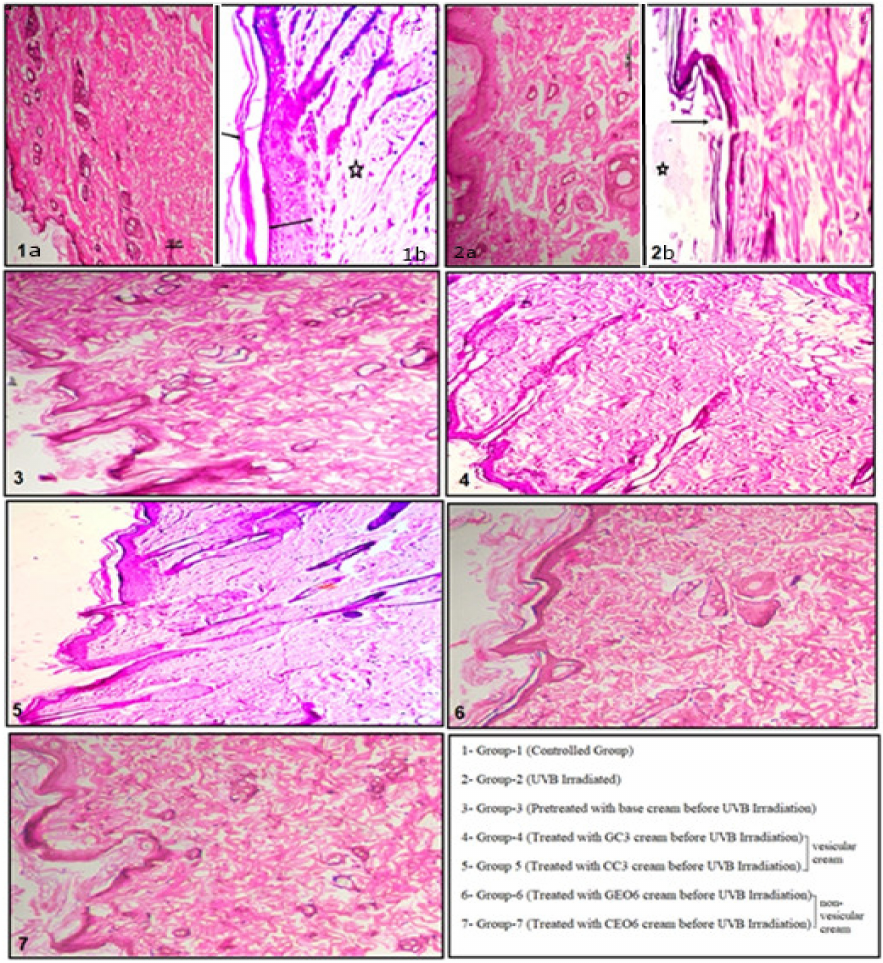
Figure 1. Histopathology of skin sections of all groups; ( 1 ( a , b )) Skin section of group 1 (Neither irra- diated nor treated with test formulation) [in 1b — line represents epidermis, arrow represents stratum corneum, asterisk represents healthy dermis]; ( 2 ( a , b )) Skin section of group 2 (UVB-irradiated); [— in 2b represents epidermis, arrow represents stratum corneum, asterisk represents healthy dermis]; ( 3 ) Skin section of Group 3 (pre-treated with Base cream + UVB-irradiated); ( 4 ) Skin section of group 4 (pretreated with GC3 formulation + UVB-irradiated); ( 5 ) Skin section of group 5 (pretreated with CC3 Formulation + UVB-irradiated); ( 6 ) Skin section of group 6 (pretreated with GEO6 Formulation + UVB-irradiated); ( 7 ) Skin section of group 7 (pretreated with GEO6 Formulation + UVB-irradiated). Overall, it could be concluded that minimum damage was observed in the skin sec- tions of groups 4 and 5 due to the prior application of EO-loaded vesicular creams.